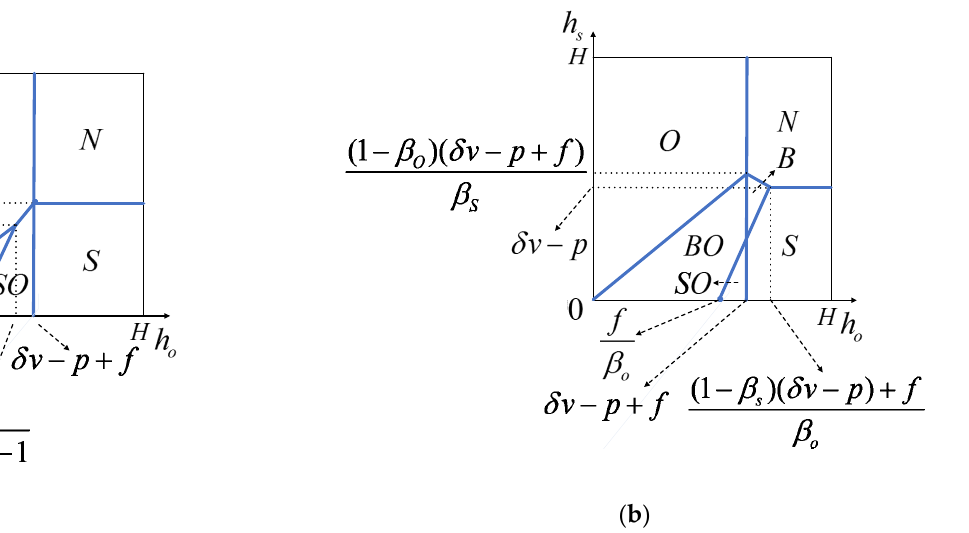
Figure 4. Market segmentation of L-type consumers when coupons are offered